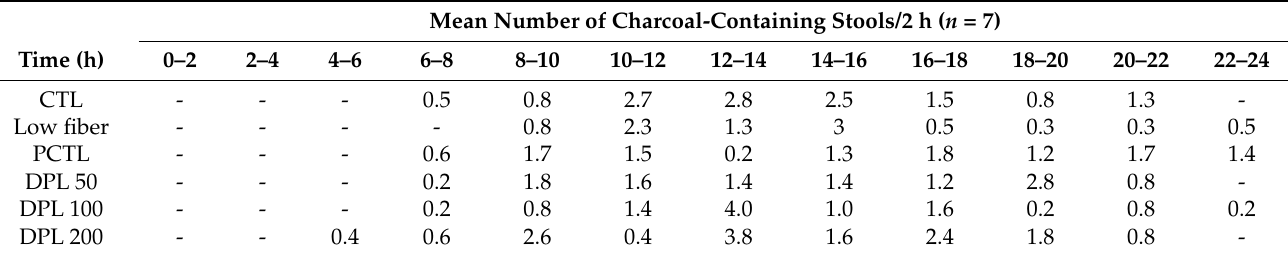
Table 2. The therapeutic effects of D. morbiferus H. L é v. leaf extract (DPL) on gastrointestinal (GI) motility in rats. Mean Number of Charcoal-Containing Stools/2 h ( n = 7)